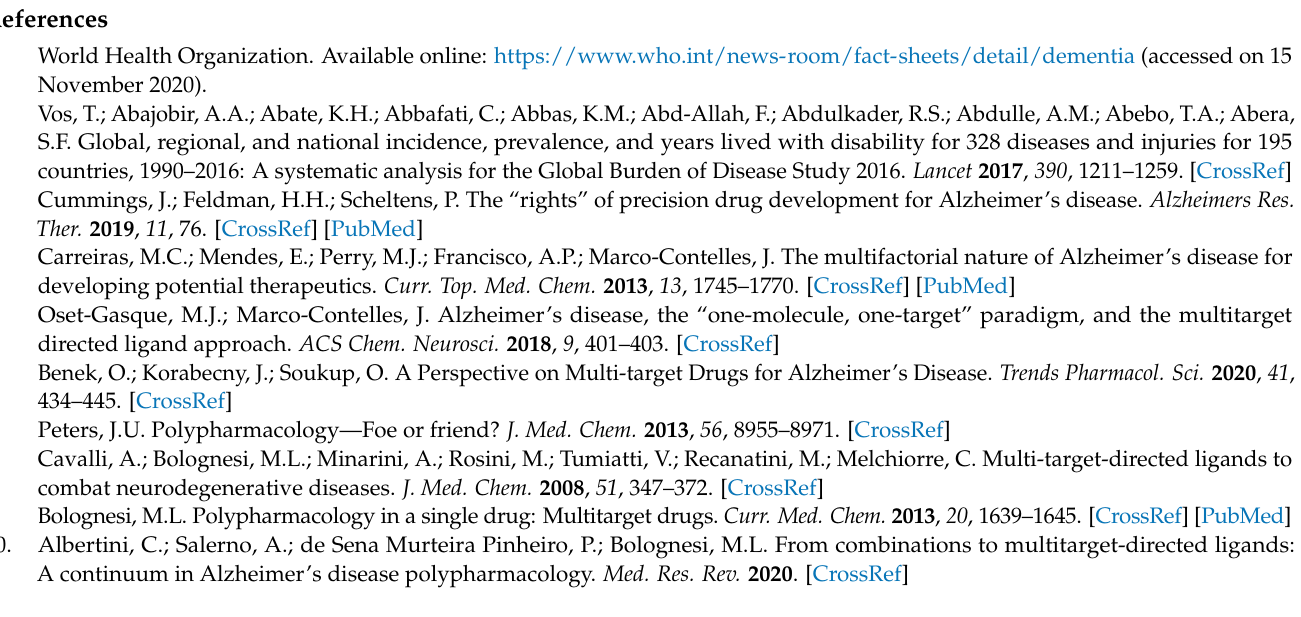
Figure S5. 1 H NMR (CDCl 3 , 400 MHz) of compound 6, Figure S6. 13 C NMR (CDCl 3 , 100 MHz) of compound 6, Figure S7. HPLC for compound 4, Figure S8. HPLC for compound 5, Figure S9. HPLC for compound 6, Scheme S1. Synthetic procedure for 5,5 (cid:48) -((2-hydroxypropane-1,3-diyl)bis(oxy))bis(N- (2-hydroxyethyl)-4-oxo-4H-chromene-2-carboxamide) (17), Figure S10 Climbing ability of A β 42 - expressing Drosophila after compound 6